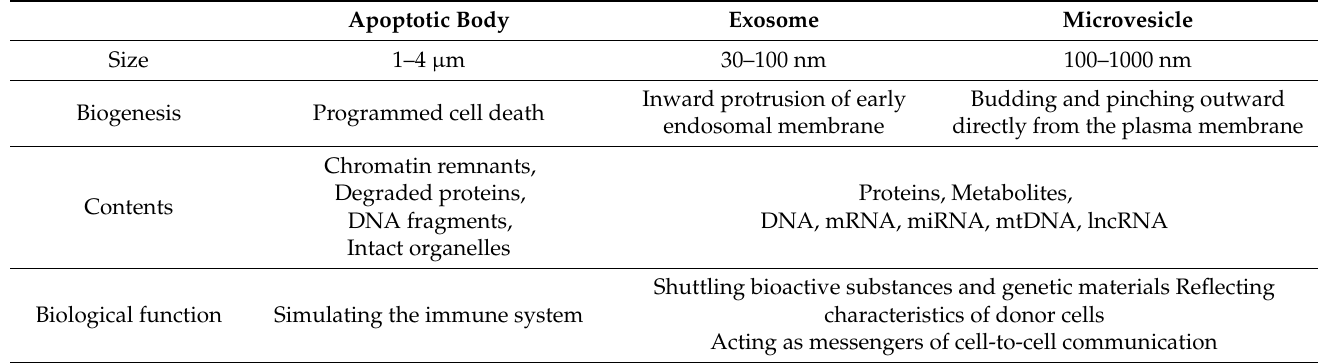
Table 1. Summary of characteristics of apoptotic body, exosome and